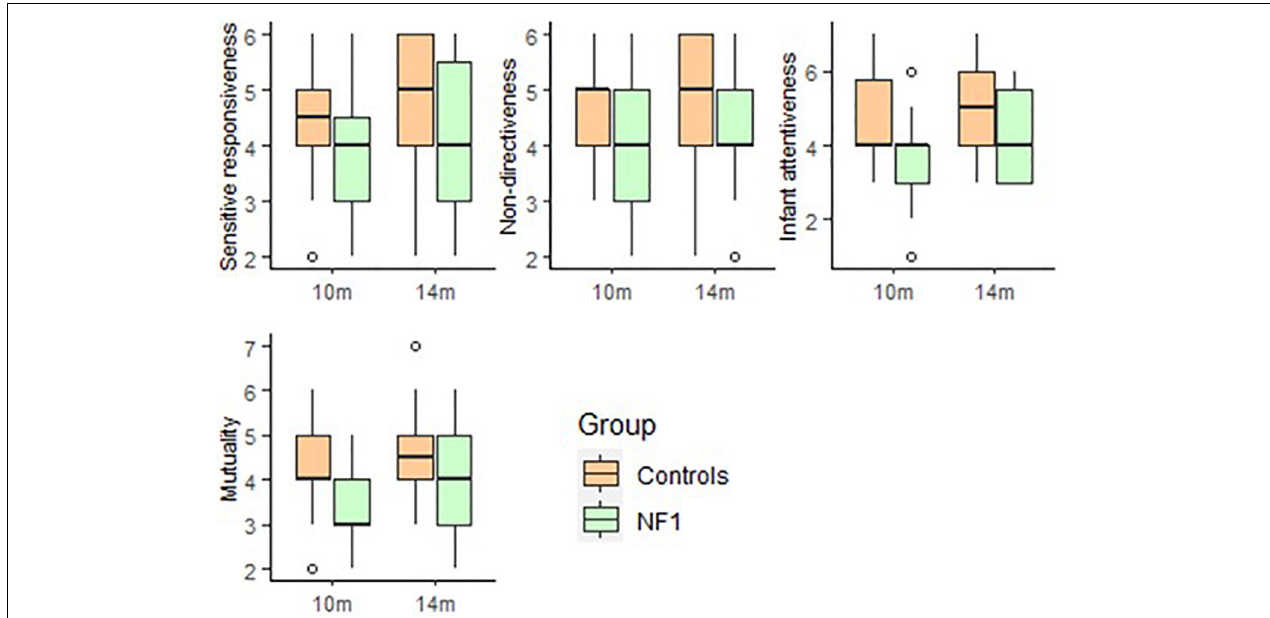
FIGURE 5 | Box-whisker plots for the NF1 and control group on the Manchester Assessment of Caregiver–Infant Interaction (MACI).